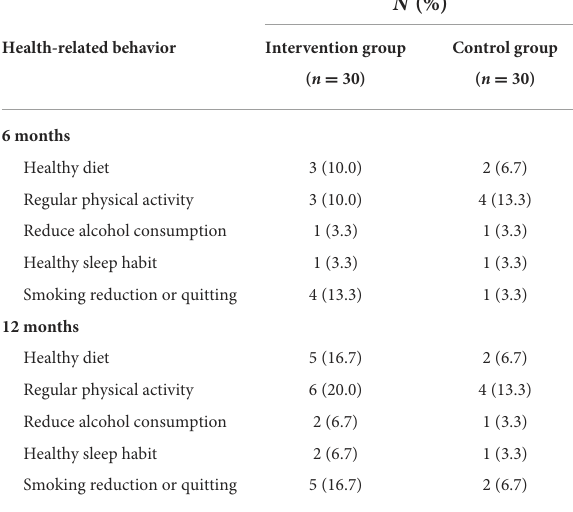
TABLE 4 Self-reported behavior change in the intervention and control groups at 6 and 12